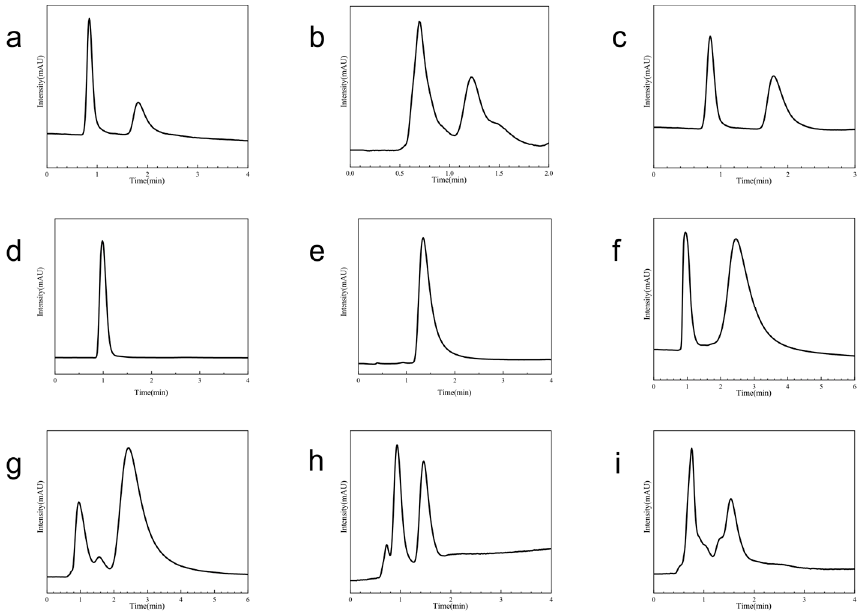
Figure 4. The chromatograms of (±)-naproxen ( a ), ketoprofen ( b ), ibuprofen ( c ), R, S-phenylethanol ( d ), R, S-1-Phenyl-1,2-ethanediol ( e ), DL-alpha-methylbenzylamine ( f ), DL-phenylglycinol ( g ), (±)-mandelic acid ( h ) and 2-amino-1,2-diphenylethanol ( i ) on the MIL − 101 − Ppa@SiO 2 column. Table 1. HPLC separation of racemates on MIL − 101 − Ppa@SiO 2 and NH 2 − MIL − 101 − Ppa@SiO 2 col- umns with hexane/isopropanol as the mobile phase and molecular docking predictions a .